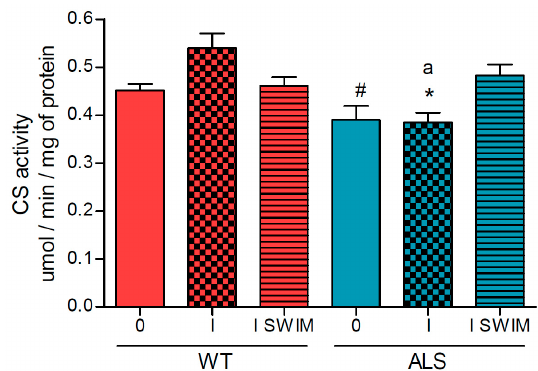
Figure 2. Citrate synthase activity in skeletal muscle of ALS and WT mice. Citrate synthase (CS) was measured in skeletal muscle homogenates. There were significant differences between the groups: * p = 0.0048, # p = 0.0075 vs. ALS I SWIM (LSD post hoc test); a p = 0.0007 between the indicated ALS and corresponding WT groups. The data are presented as the means ± SEM ( n = 8 in each group). The activity of total malate dehydrogenase (MDH) increased in the ALS I and ALS I SWIM groups (7.018 ± 0.21 and 5.982 ± 0.19 µ mol/min/mg of protein, respectively) vs. the ALS 0 group (4.300 ± 0.09 µ mol/min/mg of protein) ( p = 0.0001) and corresponding WT group of mice ( p = 0.0001).